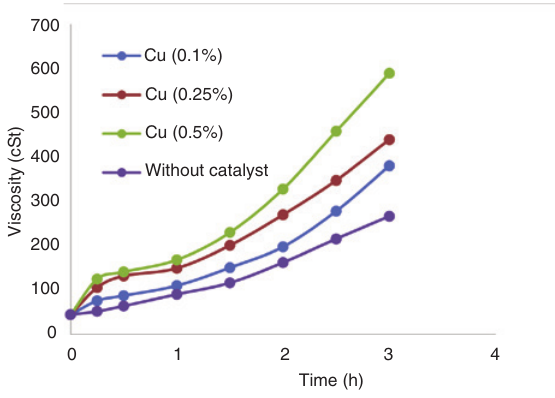
Figure 6: SEM images for (A) synthesized nickel oxide and (B) syn- thesized copper oxide.